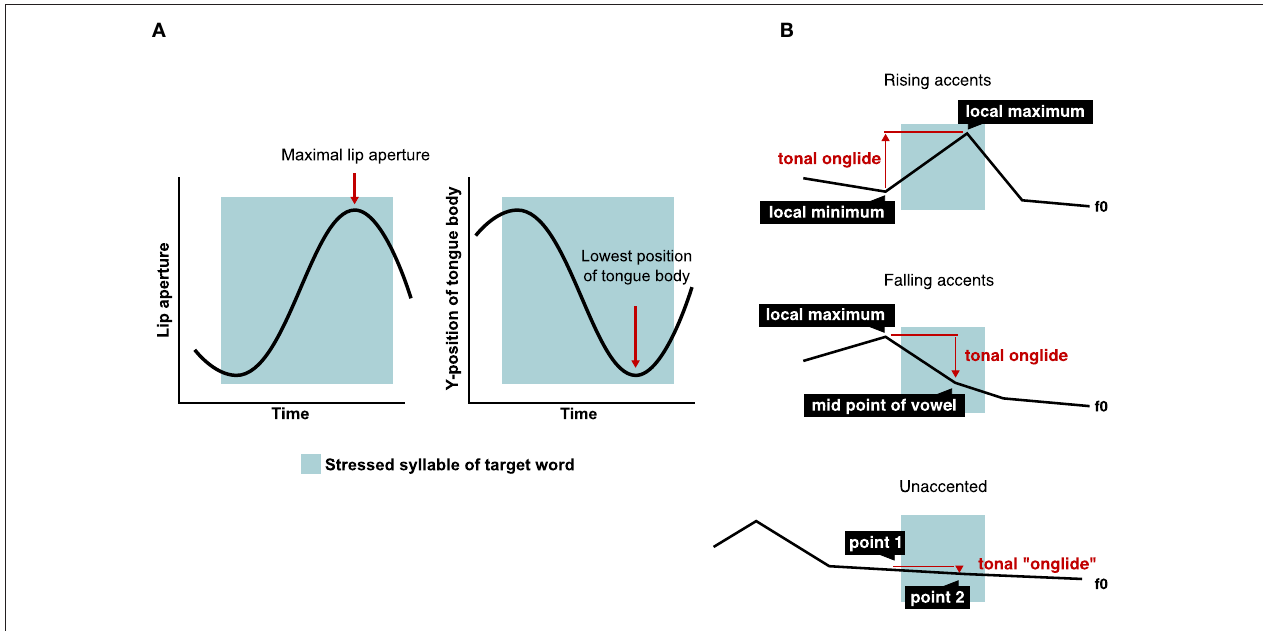
FIGURE 1 | (A) Schematic measures of maximal lip aperture (Euclidean distance) and lowest tongue body position, (B) schematic onglide